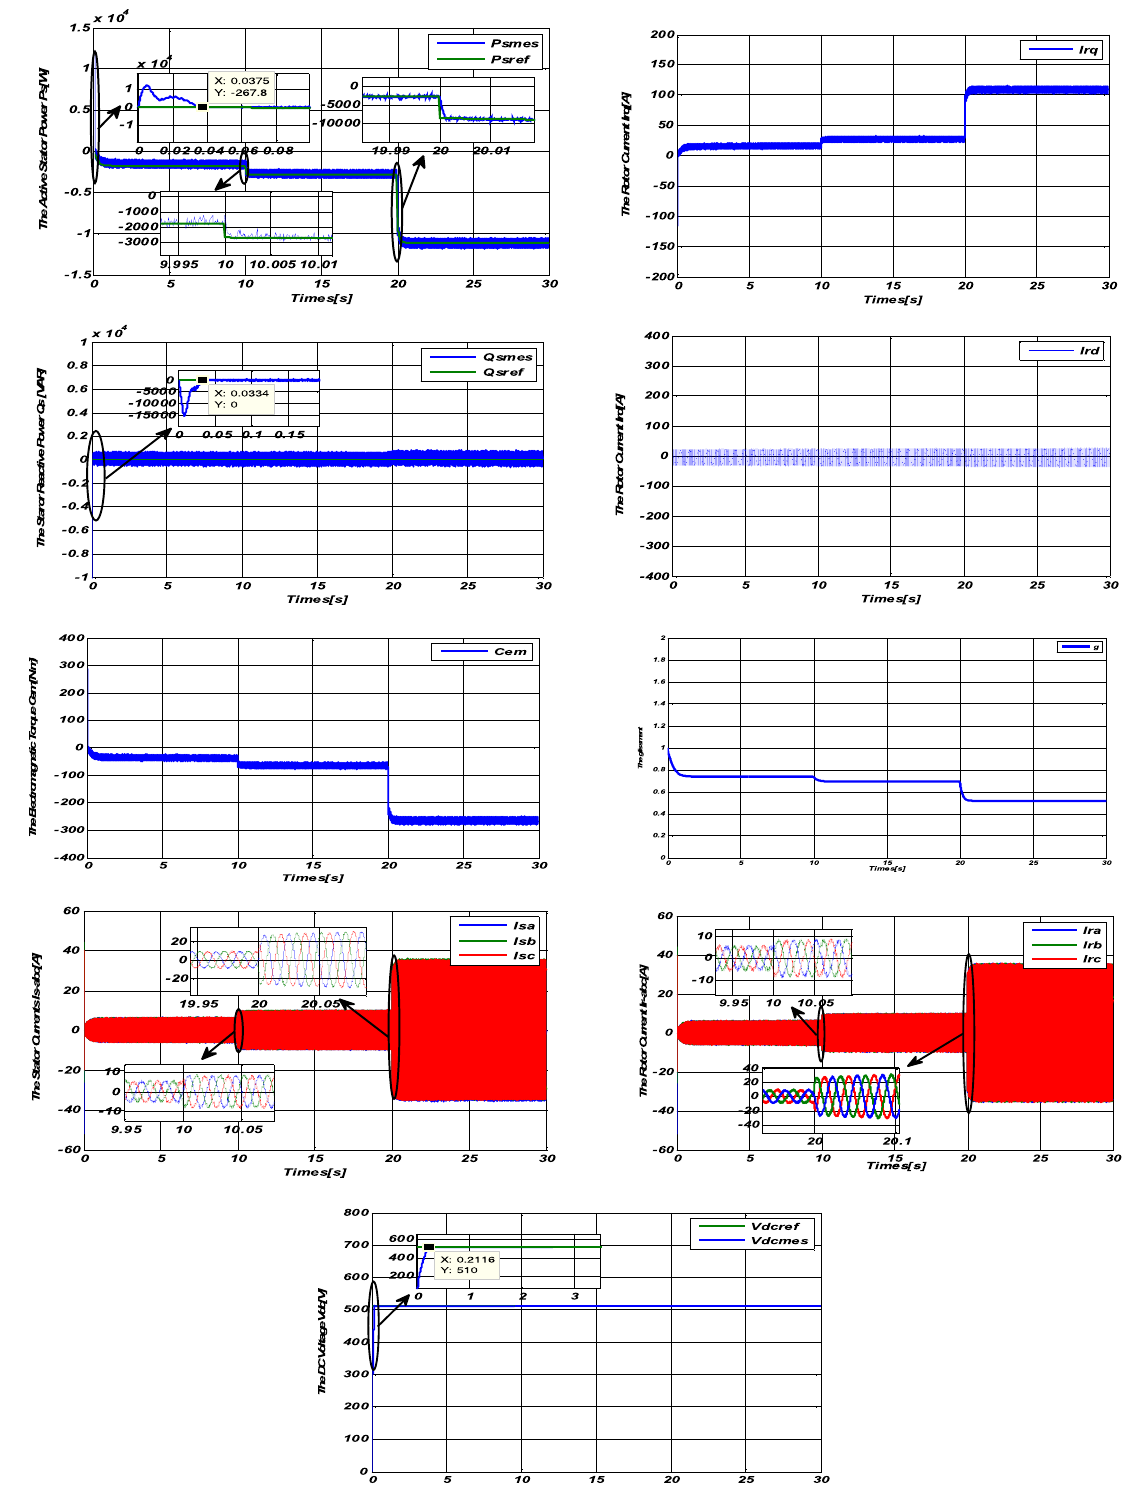
Figure 5. Results of the Sliding-Backstepping Mode control at step wind